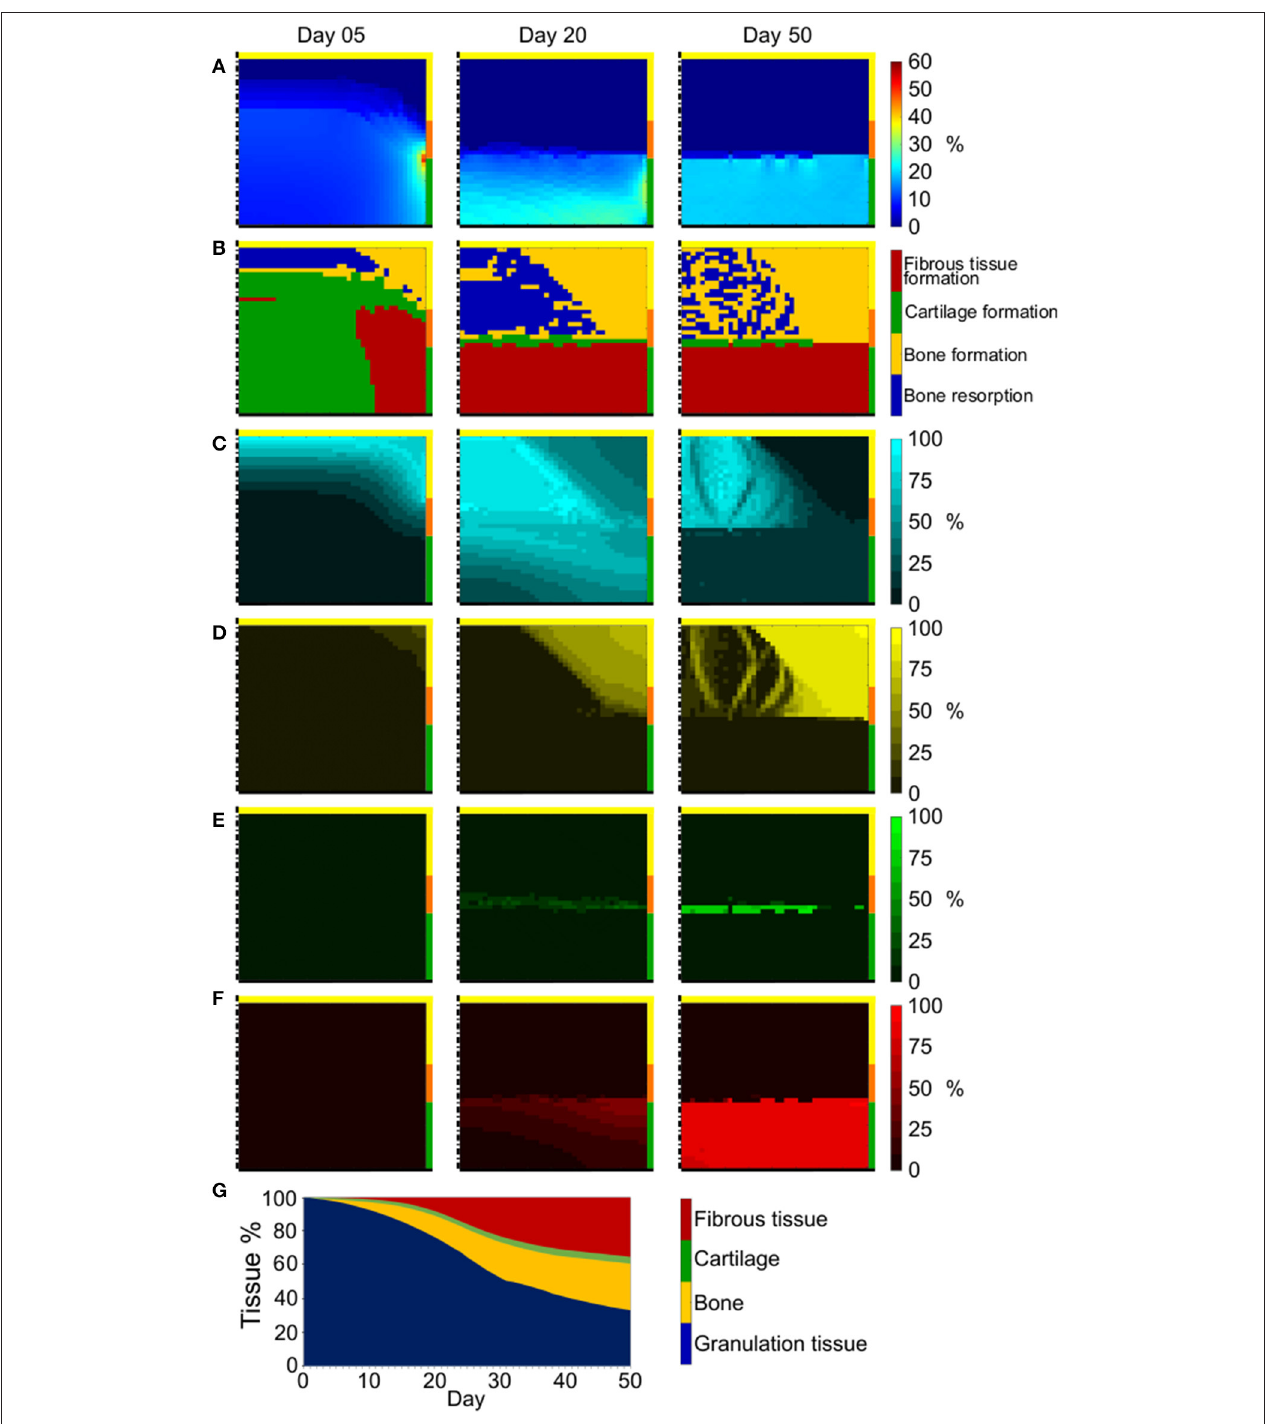
FIGURE 4 | Repair outcome of empty osteochondral defect with progenitor cell invasion from bone marrow. (A) Distribution of γ ; (B) prediction of tissue formation based on S; (C–F) amount and distribution of MSCs, osteoblasts, chondrocytes, and fibroblasts, respectively. Left, middle, and right columns show results at day 5, 20, and 50, respectively. The scale bars to interpret the plots are on the left side of the corresponding rows. The black dash-dot lines and the black solid lines mark the axis of symmetry and the articular interface, respectively. The colors of the borders indicate the neighboring tissues in the FE model of the femoral condyle: yellow, orange, and green stand for cancellous bone, subchondral bone, and cartilage, respectively; (G) quantification of tissues formed in the defect during the healing process.